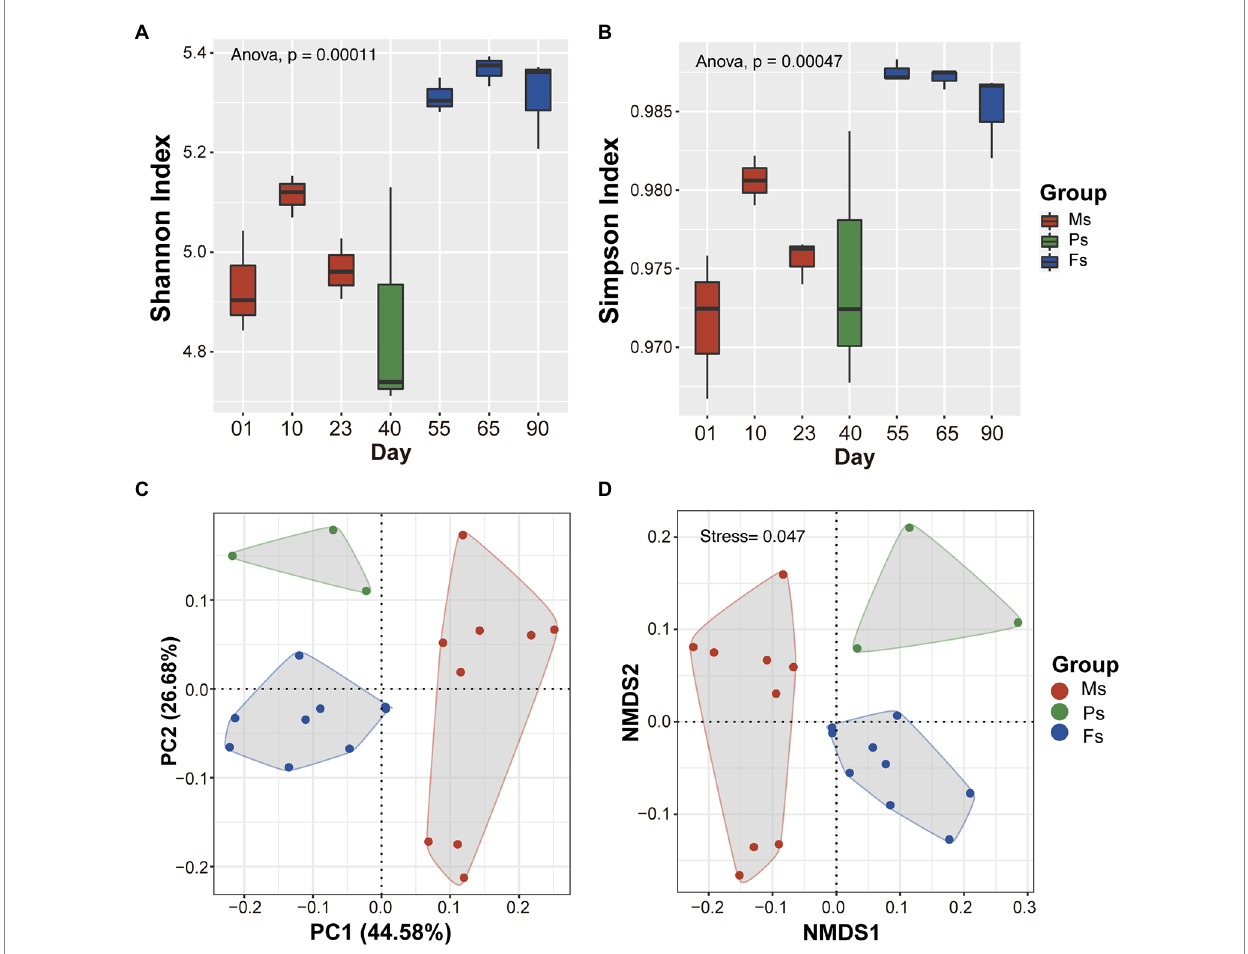
FIGURE 3 Variation in soil microbial diversity among Morchella sextelata growth stages. (A,B) Changes in microbial community alpha diversity based on Shannon’s and Simpson’s indexes. (C,D) PCoA and NMDS plots of microbial community diversity based on Bray–Curtis distances. Mycelium, primordium, and fruiting body stages are depicted in red, green, and blue, respectively. Ms, mycelium stage; Ps, primordium stage; Fs, fruiting body